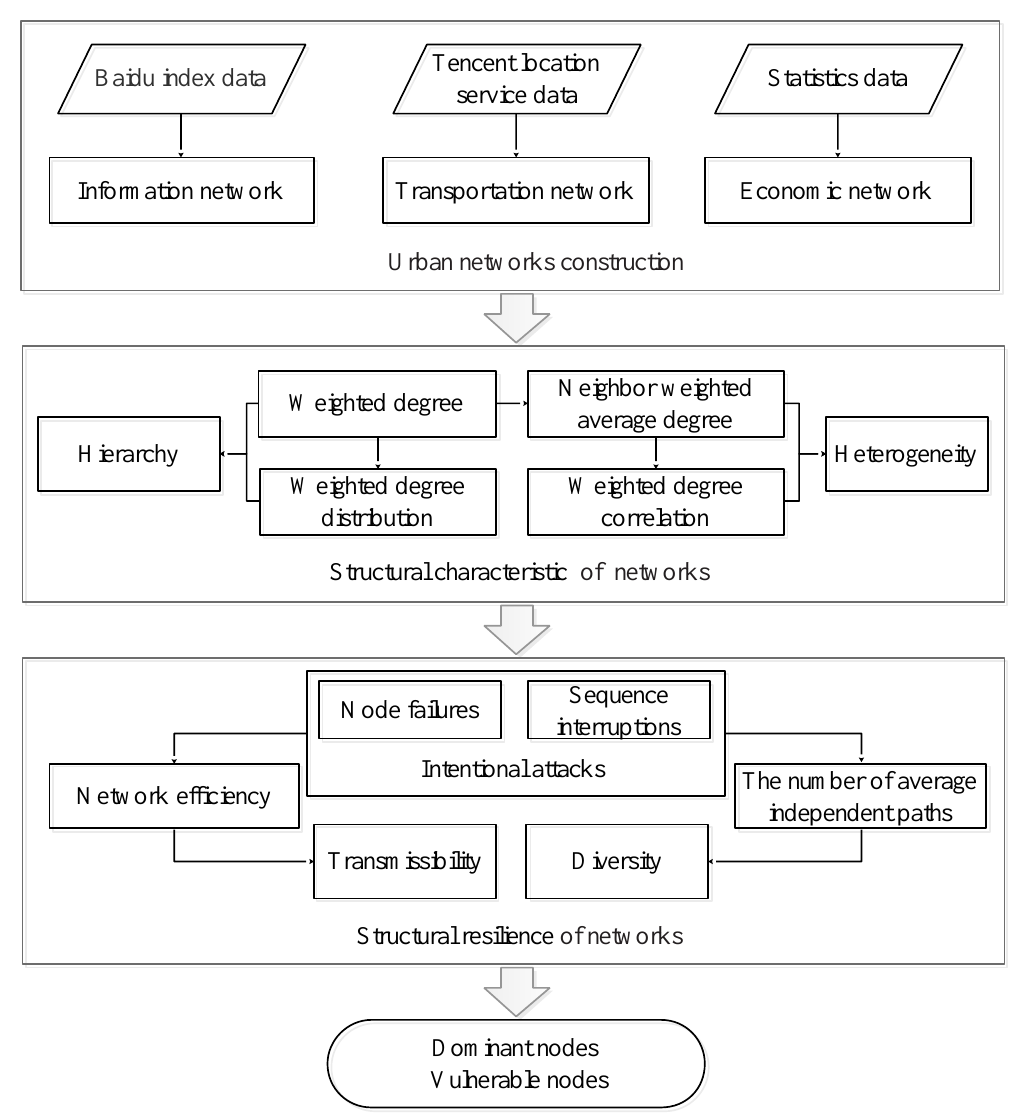
Figure 2. Framework for assessing resilience of network structure.